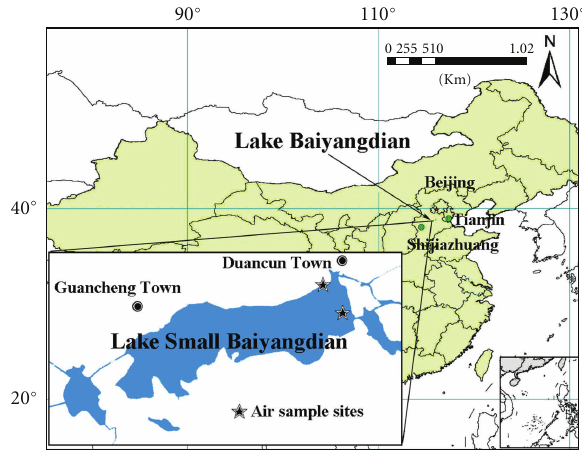
Figure 1: Location of Lake Small Baiyangdian and the sampling